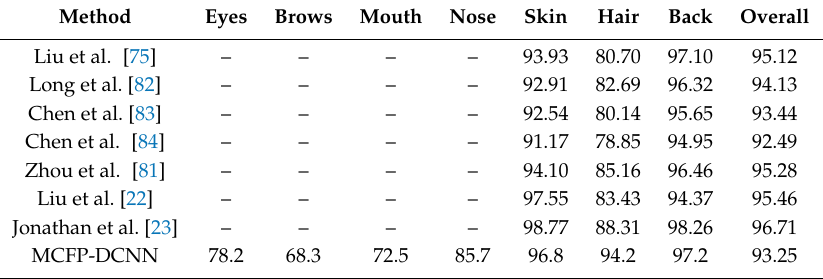
Table 5. Face parsing: comparison of the MCFP-DCNN with SOA on LFW-PL DB. The reported results are for F1